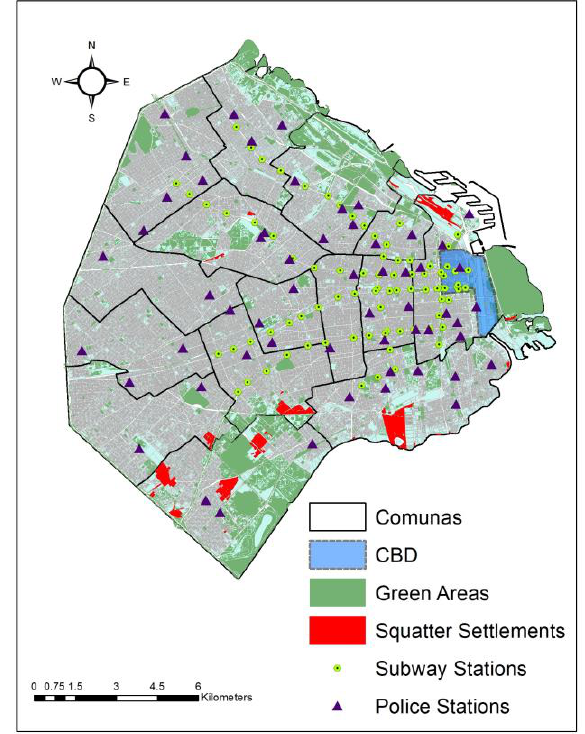
Figure 1. Cadastral map of the CBA. Squatter settlements started emerging in CBA during the 1930s. Most of the population then were internal immigrants, stigmatized for their rural background [41]. Those informal settlements were tolerated until the military regime, which came into power in 1976, initialized city’s socio-economic restructuring. This process includes the relocation of productive activities and squatter settlements outside the CBA [42]. This “cleansing” of the city forcedly evicted an estimated 208,783 squatter settlement dwellers [43]. In 1983, with the return of democracy, squatter settlements’ population resumed growing (Table 1). Table 1. Population in the squatter settlements in CBA, 1960–2010. Data from INDEC [44,45], DGEyC [46], and TECHO [47].